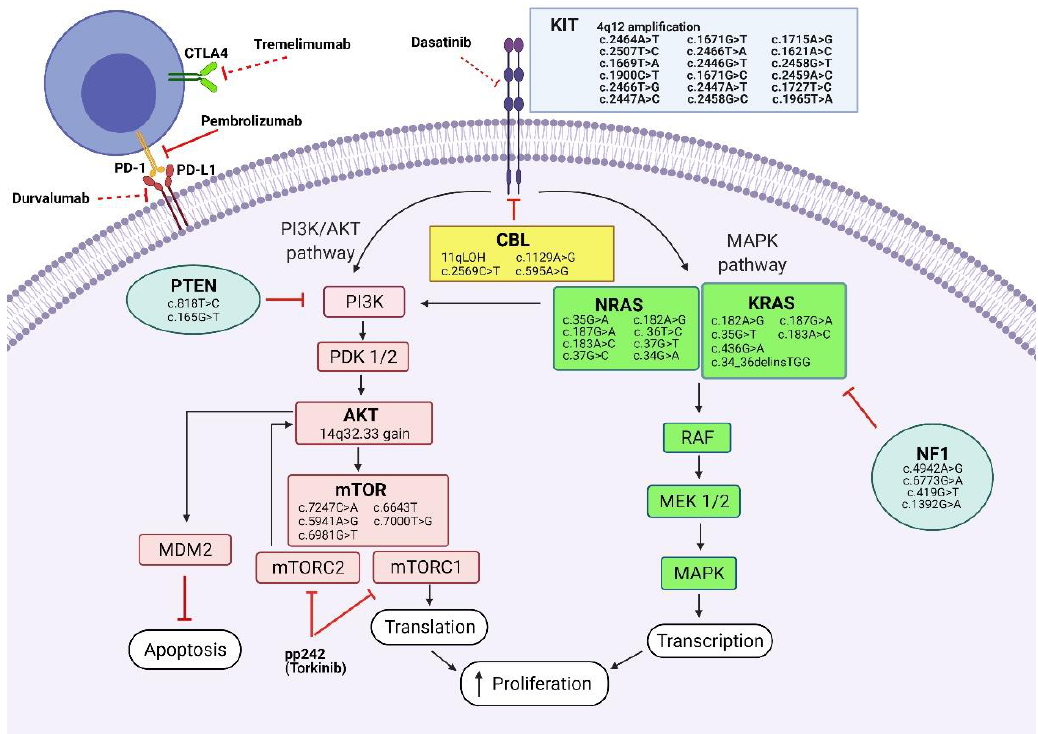
Figure 5. (Created with BioRender.com.) Signalling pathways, genetic mutations and potential targeted treatment involved in CNS germinoma development. Tumourigenesis in germinoma is stimulated through various mechanisms. Activating KIT mutations promote cell proliferation via PI3K/AKT and MAPK pathways. Molecular aberrations involving the PI3K/AKT pathway result in increased proliferation via mTORC1 and cell survival by apoptosis inhibition via mTORC2. MAPK pathway mutations promote cell proliferation. Potential targeted treatment (KIT inhibitors, immune checkpoint inhibitors, mTOR inhibitors) are presented. Gene mutations identified in CNS germinomas are depicted alongside each gene. Abbreviations: KIT: tyrosine kinase receptor; CBL: casitas B-lineage lymphoma; KRAS: Kirsten rat sarcoma viral oncogene homologue; NRAS: neuroblastoma RAS viral oncogene homolog; RAF: rapidly accelerated fibrosarcoma kinase; MEK: mitogen-activated protein/extracellular signal-regulated kinase kinase; MAPK: mitogen-activated protein kinase; PI3K: phosphatidylinositol-3-kinase; PDK: pyruvate dehydrogenase kinase; AKT: v-akt murine thymoma viral oncogene homolog; mTOR: the mechanistic target of rapamycin; mTORC—mTOR complex; PD-1: programmed cell death protein